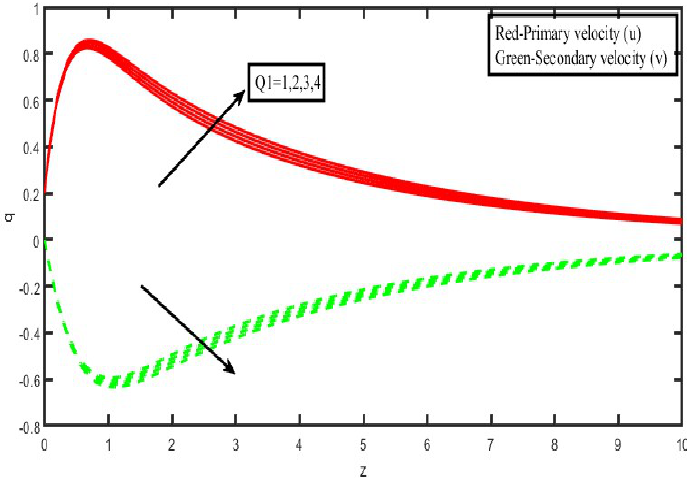
Figure 10. Velocity profiles for u and v for Radiation Absorption (Q 1 ).